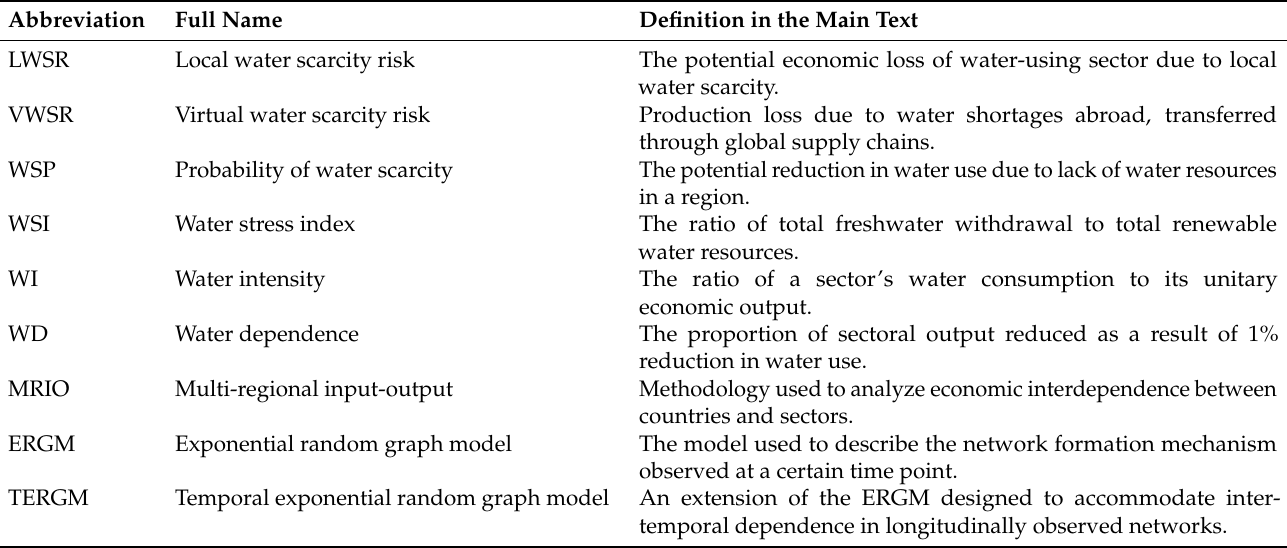
Table A2. Abbreviation list with